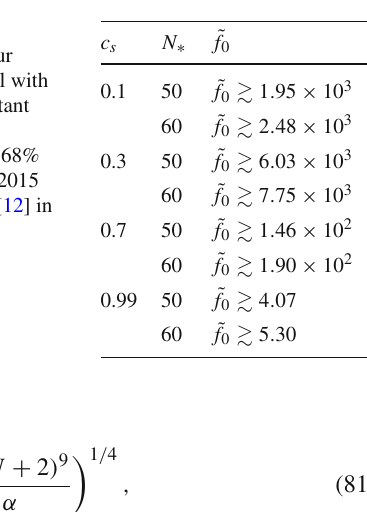
Fig. 1 The r − n s diagram of the quartic potential (35) in the cold and warm DBI inflationary settings. The dashed and solid lines are related to N ∗ = 50 and N ∗ = 60, respectively. The marginalized joint 68% and respectively